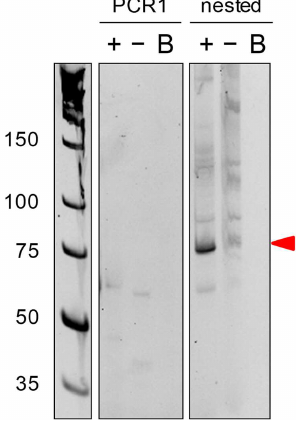
Figure 3. PCR result. PCR1 was performed using distal primers in the presence of CMC treatment (+), in absence of CMC treatment (−), or without cDNA (B). Since the PCR1 did not produce any amplicons, we performed nested PCR using nested primers. The amplicon of the correct size is shown by the red arrow.